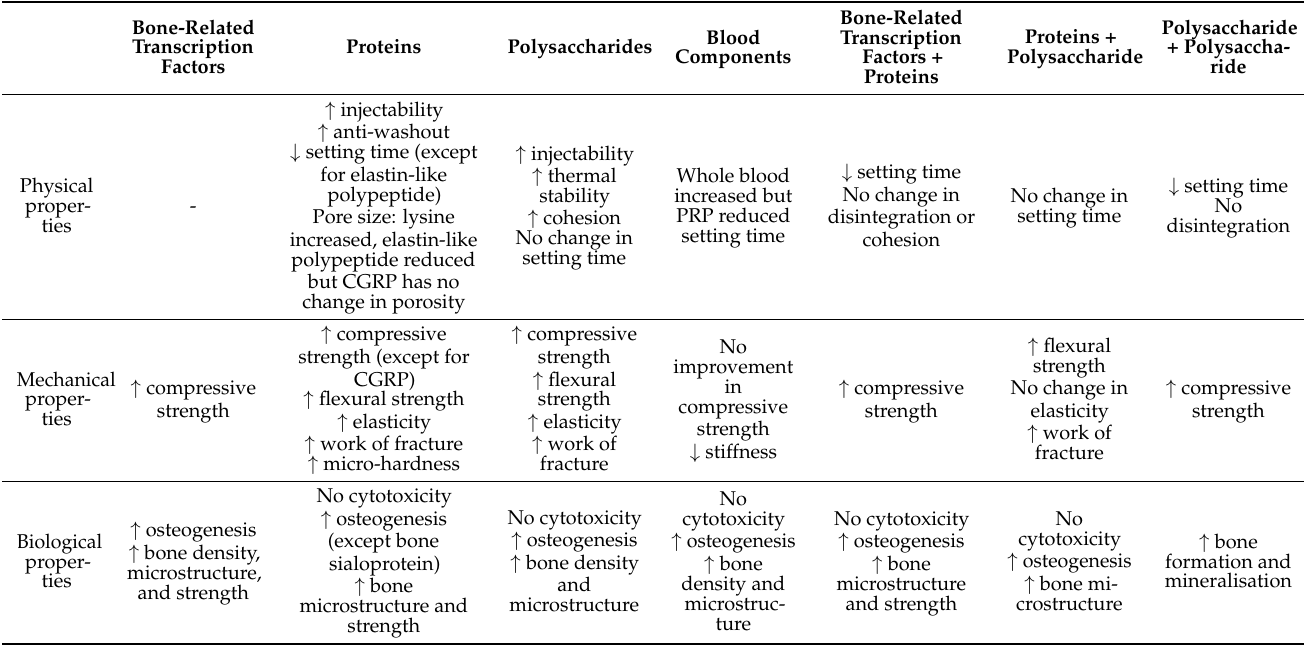
Table 7. Summary on the characteristics of CPC after incorporation of biological